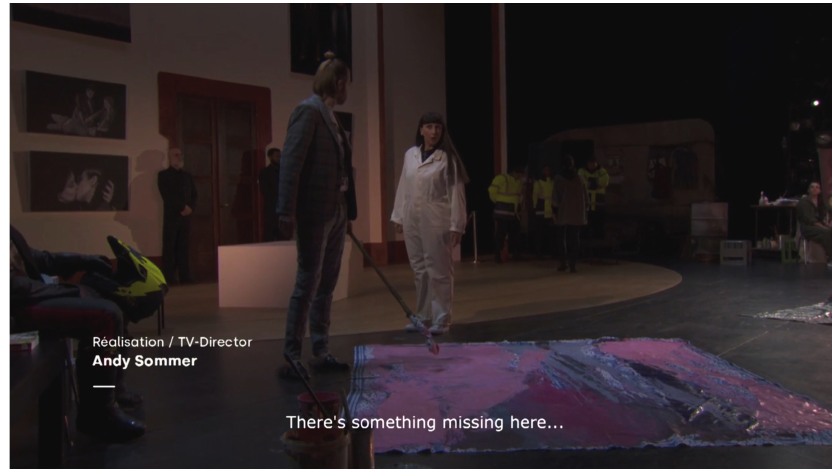
Fig. 1 Serena Farnocchia/Vitellia and Bernard Richter/Tito at the beginning of the show. Still frame from the streamed performance on GTG Digital (February 19,